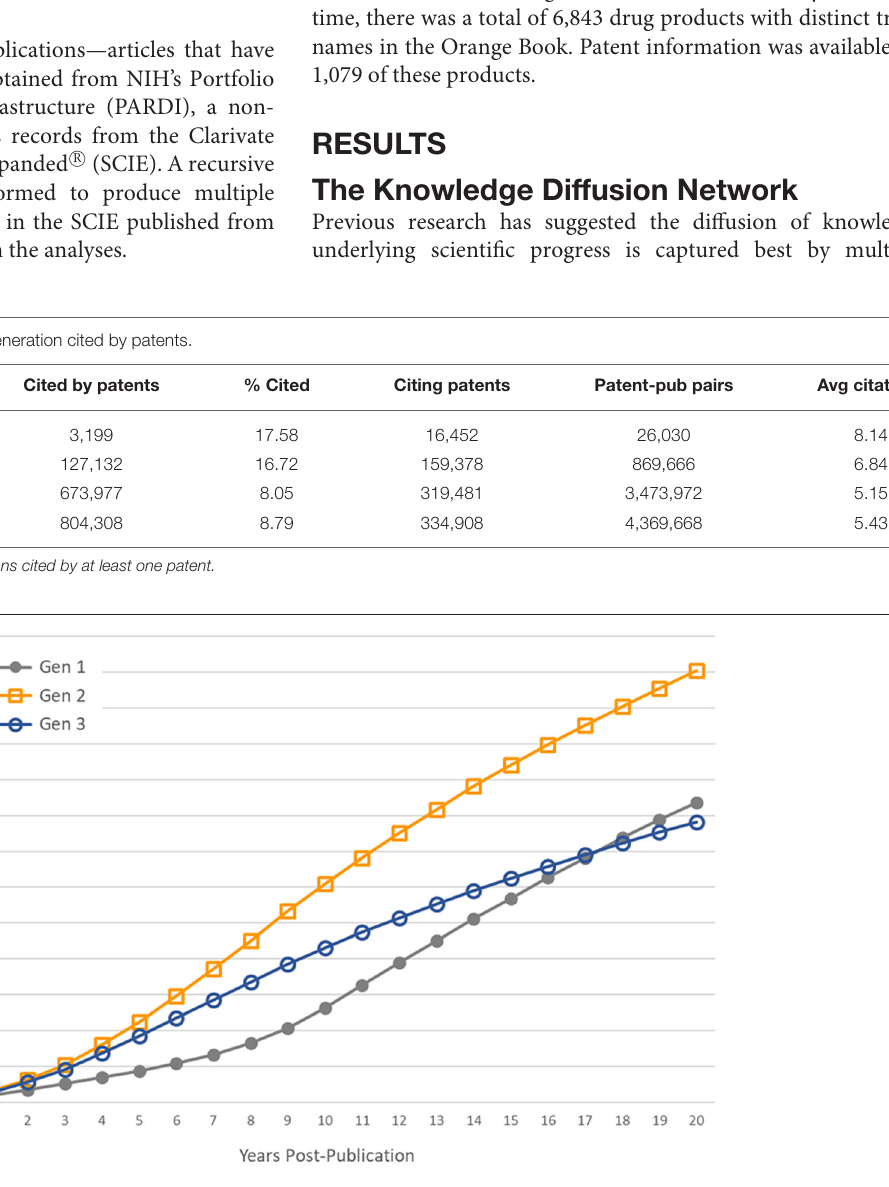
FIGURE 4 | Controlling for censored time series data. Average cumulative number of patent citations to papers published in the year 1993 and earlier, by generation.